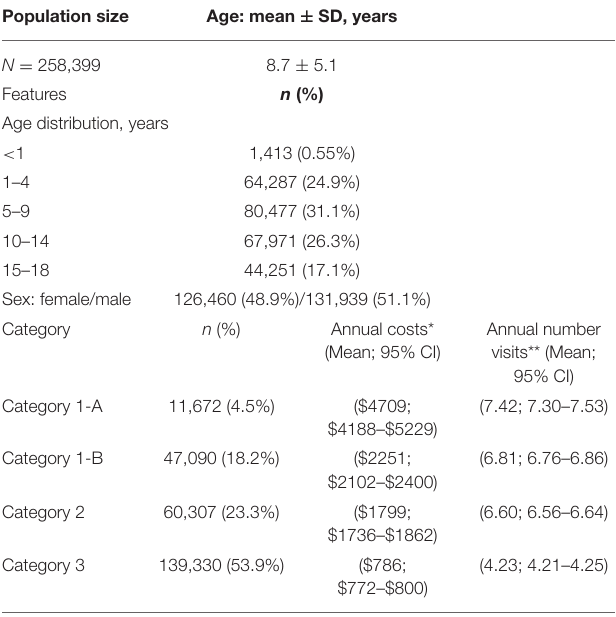
TABLE 2 | Demographic features and summary statistics of study